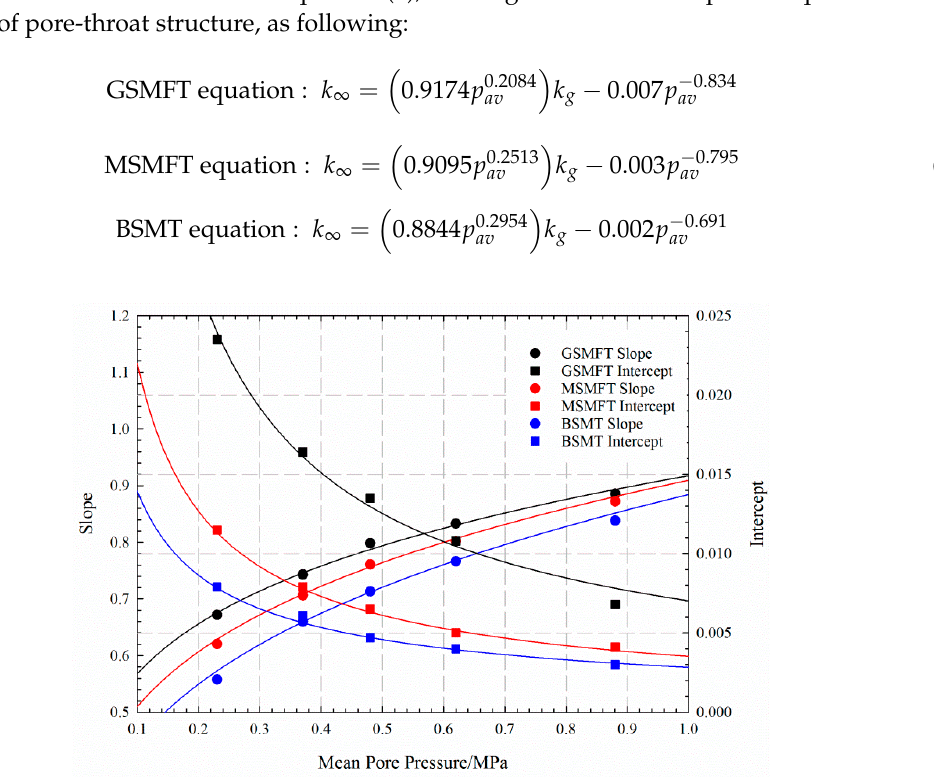
Figure 13. Slope and intercept versus mean pore pressure for different pore-throat structure types.